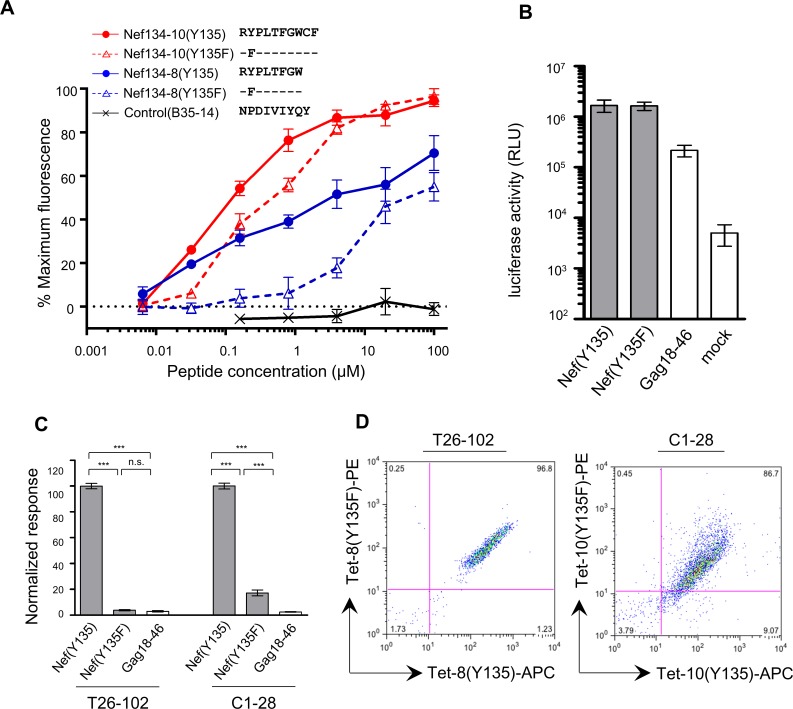
A*24:02 stabilization and endogenous antigen presentation assays.(A) A*24:02 stabilization assay. Binding of Nef134-8 (blue circles) and Nef134-10 (red circles) and their Y135F-containing peptide variants (blue and red triangles, respectively) to T2 cells expressing A*24:02 was measured. Symbols and error bars denote the mean and SEM, respectively. A peptide derived from an HLA-B*35-restricted epitope in HIV-1 reverse transcriptase (B35-14) served as a negative control. % maximum fluorescence was calculated by dividing the MFI of the sample by the maximal MFI in all measured samples in each experiment in each independent experiment. (B) Renilla luciferase (hRluc) activity after transfection of the minigene expressing Nef(Y135), Nef(Y135F), Gag18-46 fused to hRluc or mock controls (culture without transfection). Histograms and error bars denote the mean and SD of triplicate cocultures performed in 3 independent experiments. RLU: Relative light units. (C) Recognition of endogenously expressed epitopes derived from Nef(Y135), Nef(Y135F) and Gag18-46 minigenes by dually specific CTL clones T26-102 or C1-28. Histograms and error bars denote the mean and SEM of replicate IFN-γ ELISA measurements derived from triplicate co-cultures performed in 3 independent experiments. Results are normalized to the mean IFN-γ concentration generated by CTL clones upon co-culture with Nef(Y135)-expressing cells. Asterisks (***) denote p < 0.001 calculated using the Tukey post-test after one-way ANOVA. (D) Double-tetramer staining of CTL clone T26-102 with A*24:02/Nef134-8(Y135) tetramer-allophycocyanin (Tet-8(Y135)-APC) and A*24:02/Nef134-8(Y135F) tetramer-phycoerythrin (Tet-8(Y135F)-PE) (left) and CTL clone C1-28 with A*24:02/Nef134-10(Y135) tetramer-allophycocyanin (Tet-10(Y135)-APC) and A*24:02/Nef134-10(Y135F) tetramer-phycoerythrin (Tet-10(Y135F)-PE) (right).